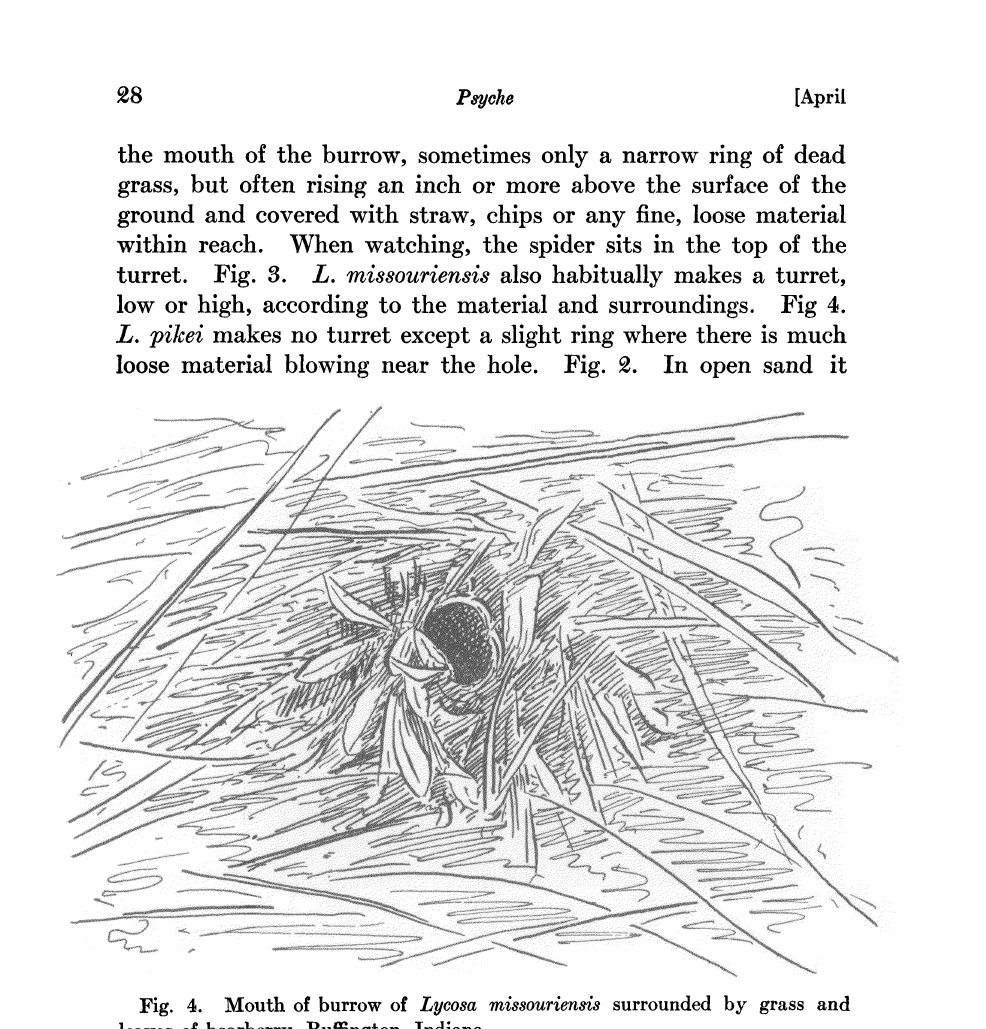
Fig. 4. Mouth of burrow of Lycosa missouriensis surrounded by grass and leaves of bearberry, Bungton,